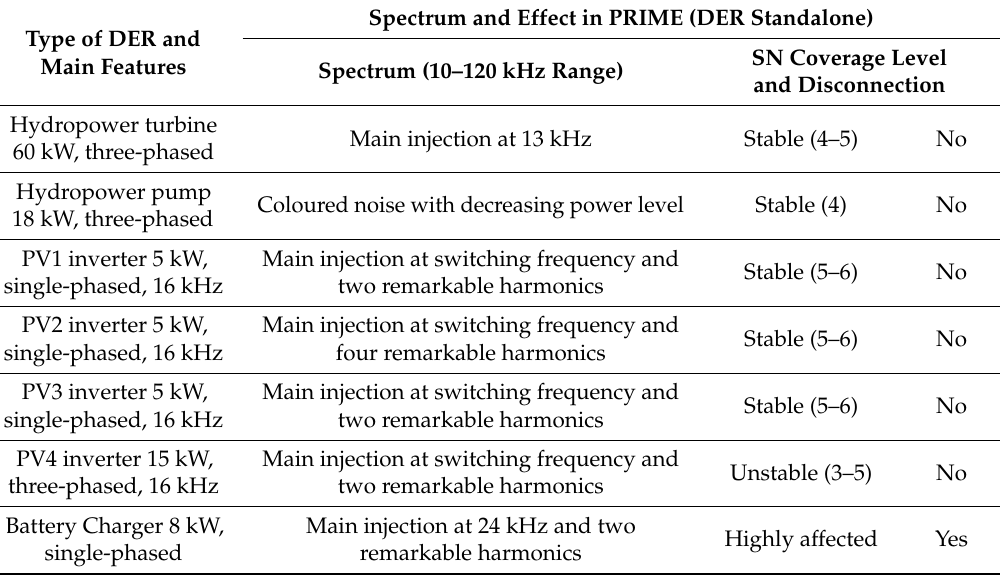
Table 3. List of considered devices and summary of their influence over